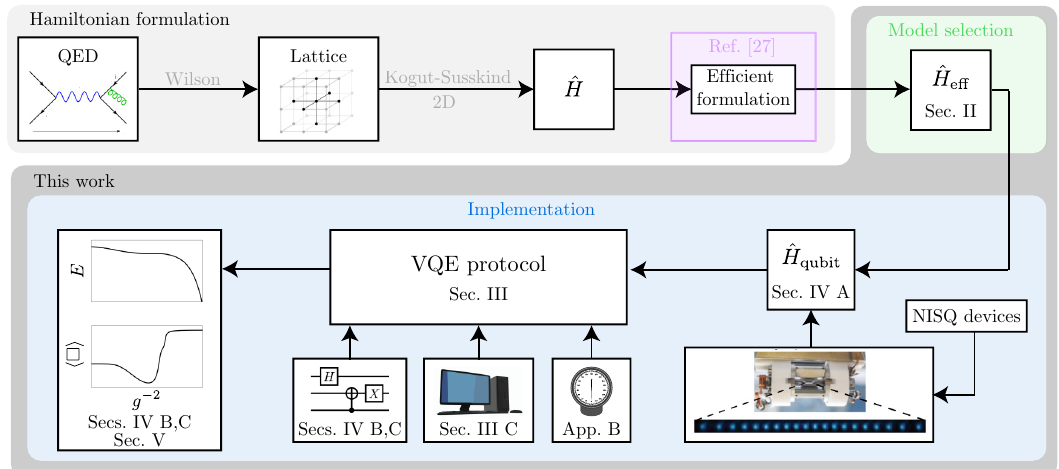
FIG. 1. The blueprint for quantum simulations of lattice gauge theories. As described in Sec. III, we use a VQE to simulate QED. The ingredients to perform the VQE are quantum circuits (Secs. IV B and IV C), a classical optimizer (Sec. III), and a measurement scheme to estimate the energy of a quantum state (Appendix B). As described in Sec. IV A, the VQE requires a Hamiltonian ˆ H qubit cast in terms of qubit operators. ˆ H qubit is optimized for ion-trap quantum computers (see the figure) but can be used with any platform. In turn, ˆ H qubit is obtained from an effective Hamiltonian ˆ H eff , which is derived in Sec. II from the results of Ref. [28]. As schematically indicated in the “Hamiltonian formulation” box, Ref. [28] uses the Kogut-Susskind [29] formulation of two-dimensional (2D) lattice gauge theories (LGTs), the continuum limits of which correspond to QED. The outcomes of simulated VQEs are presented in Secs. IV B and IV C, while the corresponding analytical results are given in Sec. V. The images of the lattice and the ion-trap quantum computer are from Refs. [30] and [22],